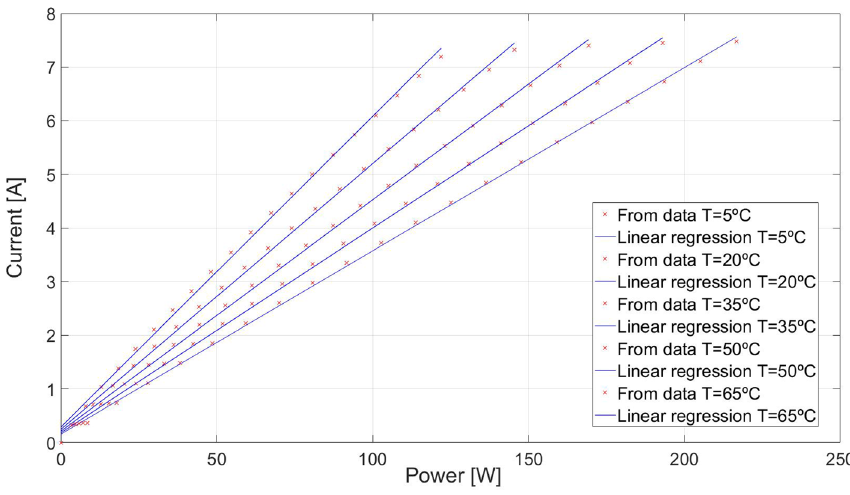
Figure 4. Maximum power vs optimal current curves for different